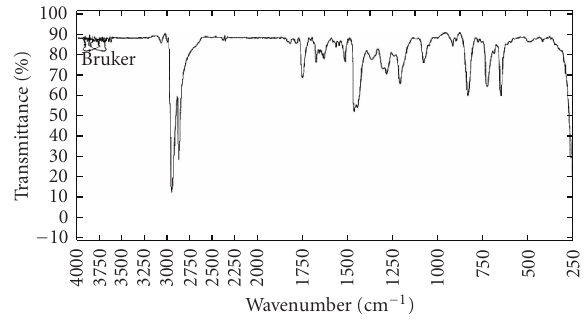
Figure 1: FT-IR spectrum of poly[3-(6-clorohexyl)thiophene].